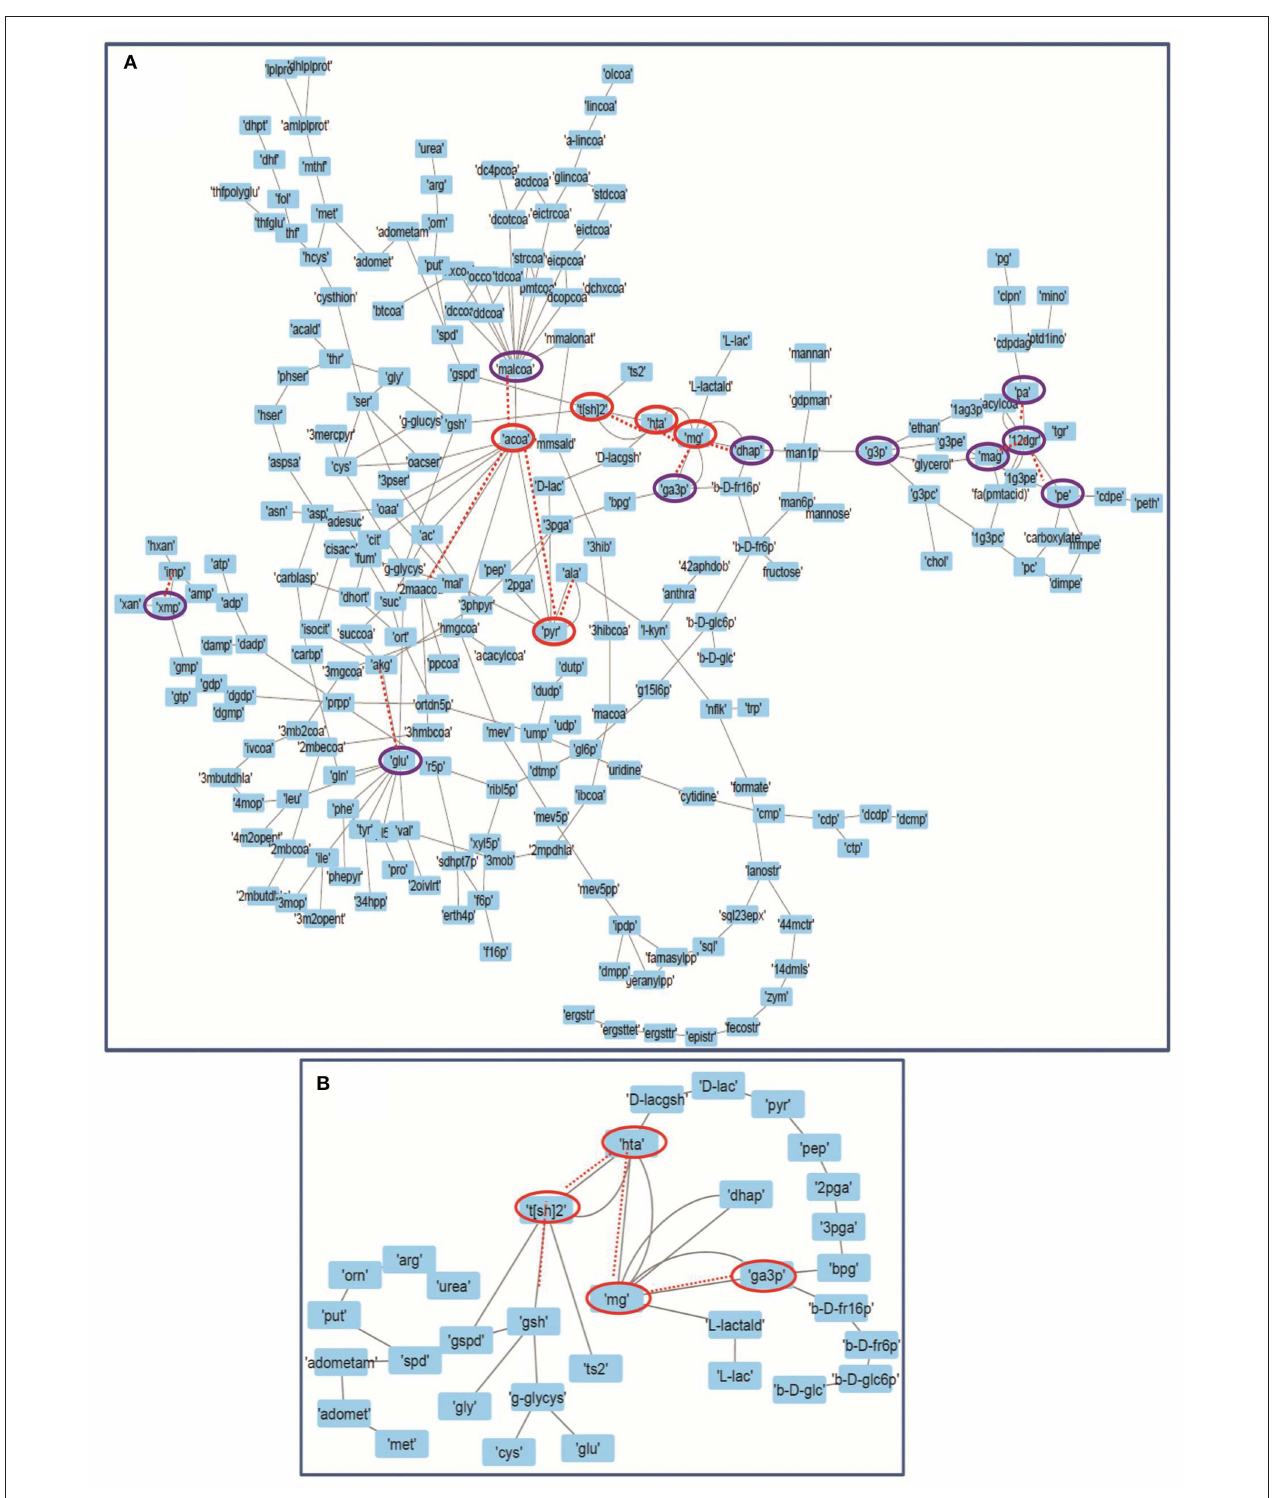
FIGURE 7 | Depicting the internal connectivity in (A) Master model, and (B) M7 model. The components are connected by backbone forming high curvature nodes [encircled in red color (top 5) and purple (next top 10)]. Low curvature nodes are shown without encircled nodes. High curvature nodes act as bridges between major network communities and play important role in determining structural and functional organization of network. Dotted lines depicting the connection of high curvature nodes with important individual network communities.